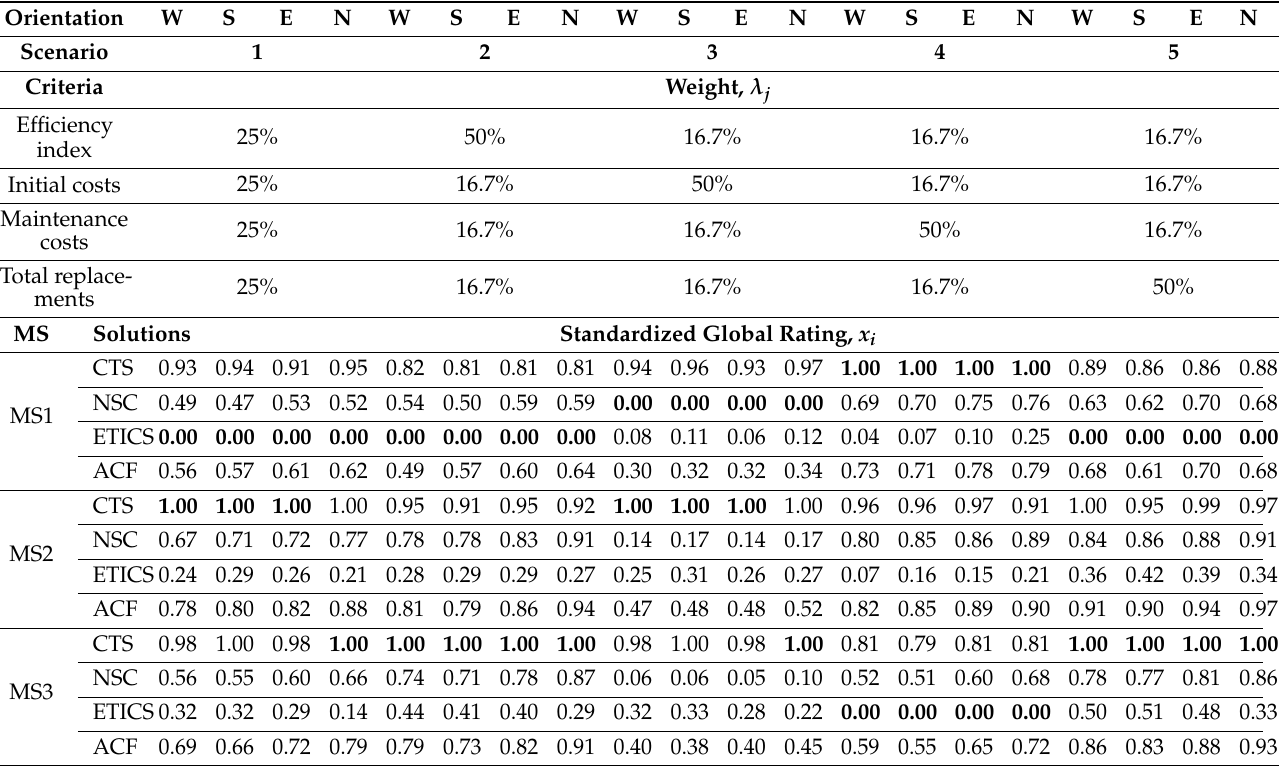
Table 6. Multi-criteria decision analysis for